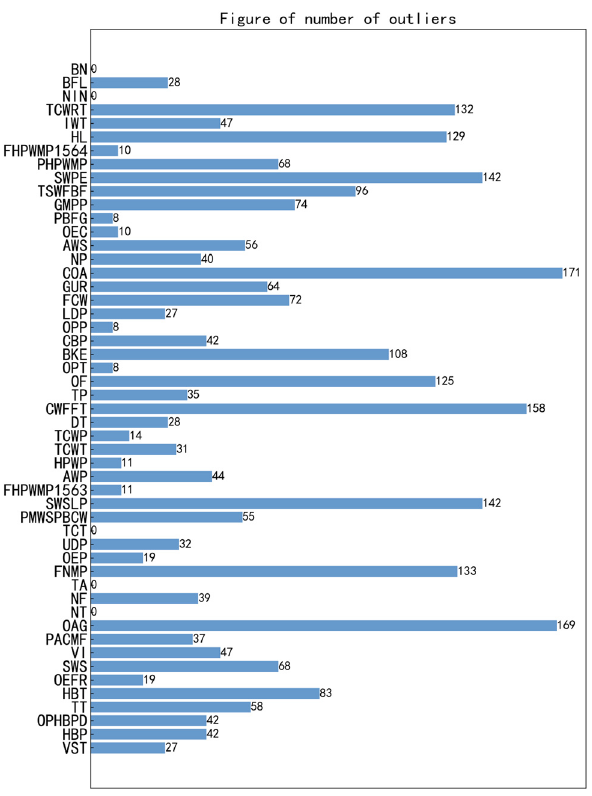
Figure 1: Number of outliers for each